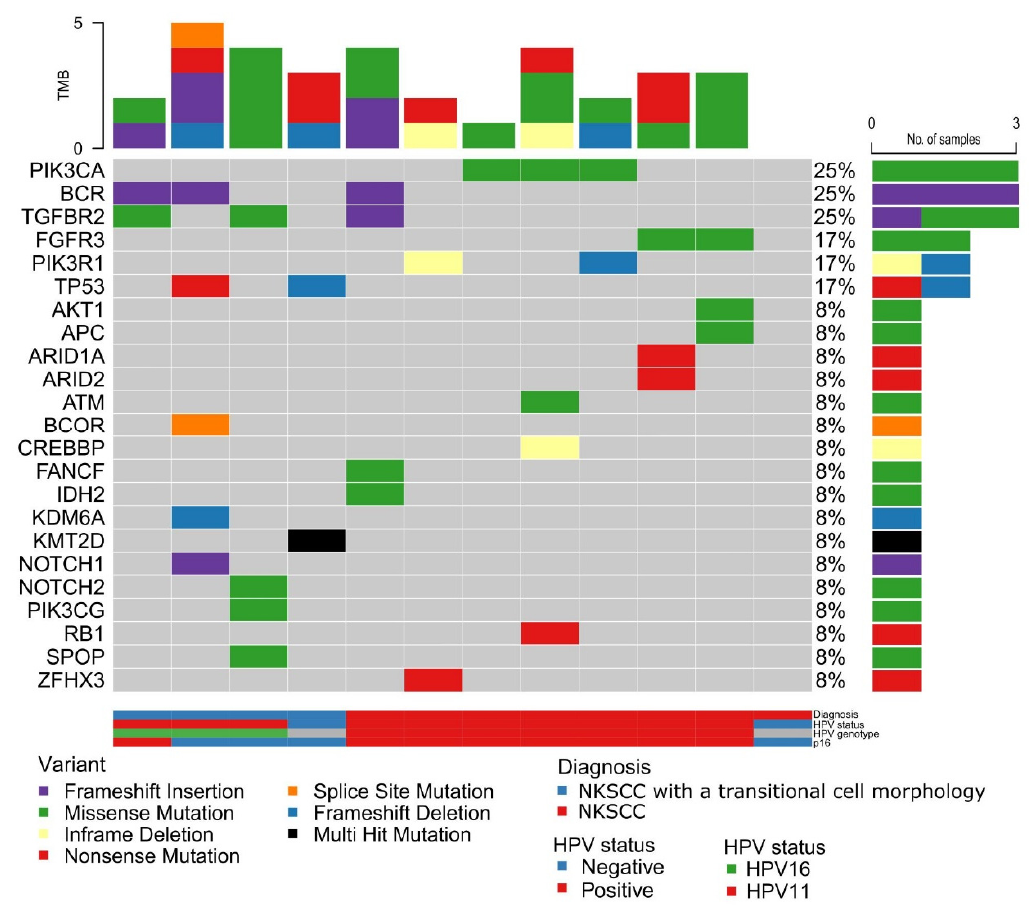
Figure 4. HPV status and somatic mutations in squamous cell carcinomas of the lacrimal drainage system. Six out of seven HPV16-positive SCC harbored mutations in the PI3K-AKT signaling pathway. PIK3CA (p.E542K, p.E545K, p.R115L), BCR (p.V1094fs*17), TGFBR2 (p.A275E, p.K277N), FGFR3 (p.S249C), PIK3R1 (p.N673fs*18, c.174635_1748del), and TP53 (p.Q331*,